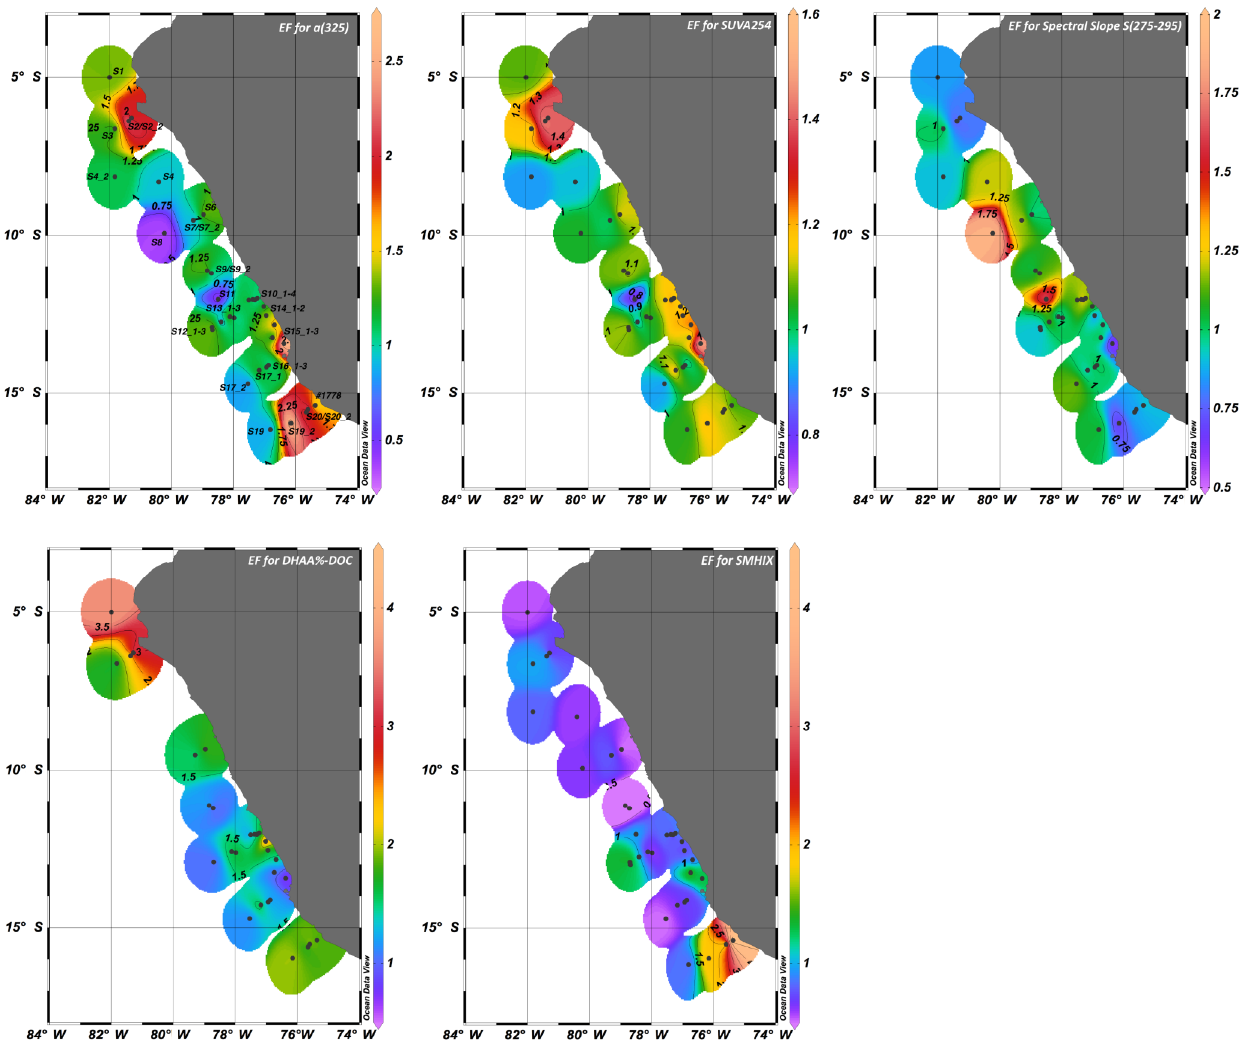
Figure 5. Enrichment factors (EFs) in the Peruvian upwelling region. From the top left, EF for absorption coefficient measured at 325nm both in SML and ULW, spectral slope parameter S (275–295) as indicator for changes in DOM molecular weight, SUVA 254 as indicator for DOM aromatic content, DHAA%-DOC as indicator of DOM lability, and SMHIX as indicator of humic content of DOM.